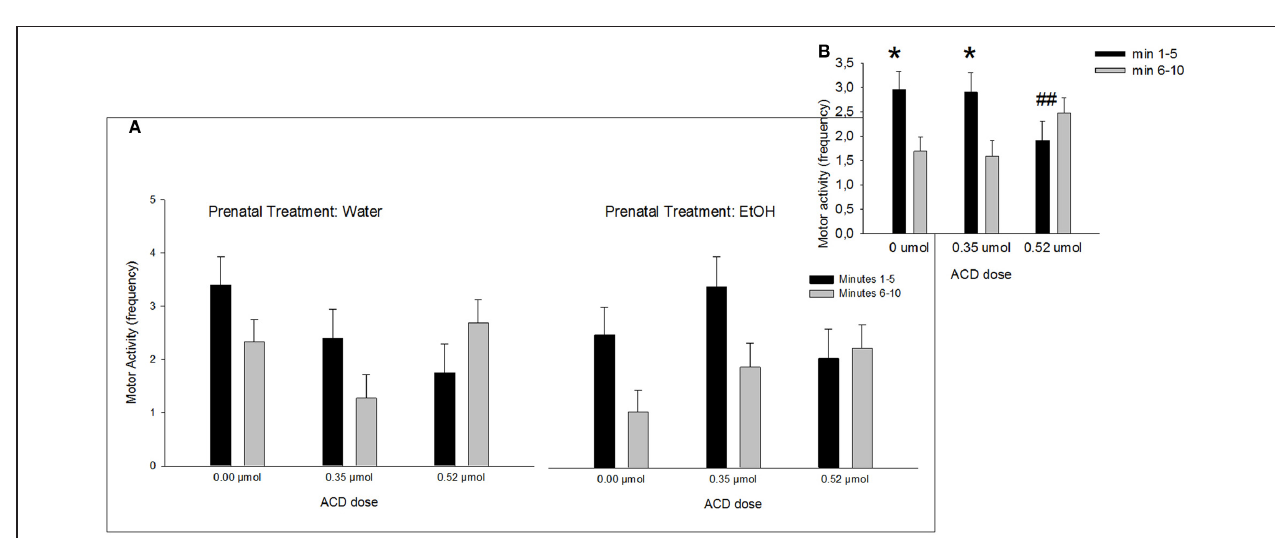
prenatal treatments. Asterisk ( ∗ p < 0 . 01) depicts a significant difference between time intervals in the same ACD dose. Double numeral ( ## p < 0 . 01) indicates a significant difference between doses during minutes in block